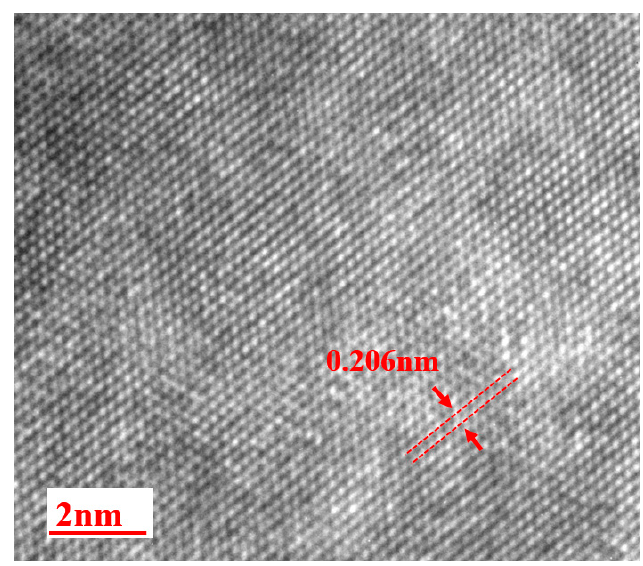
Figure 9. HRTEM micrograph of the deposited single crystal diamond.